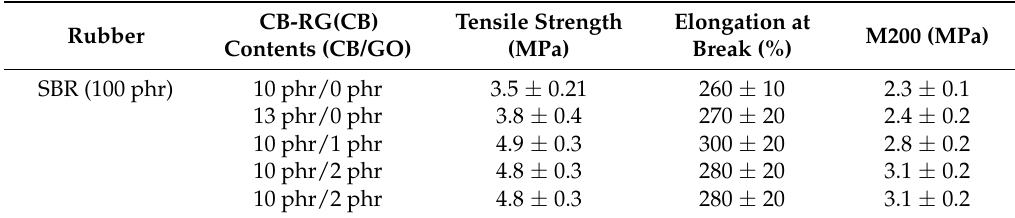
Table 7. Mechanical Properties and Volume Resistivity of SBR/CB-RG(CB) Composites (Modified). Reproduced with permission from [87], Copyright Wiley,